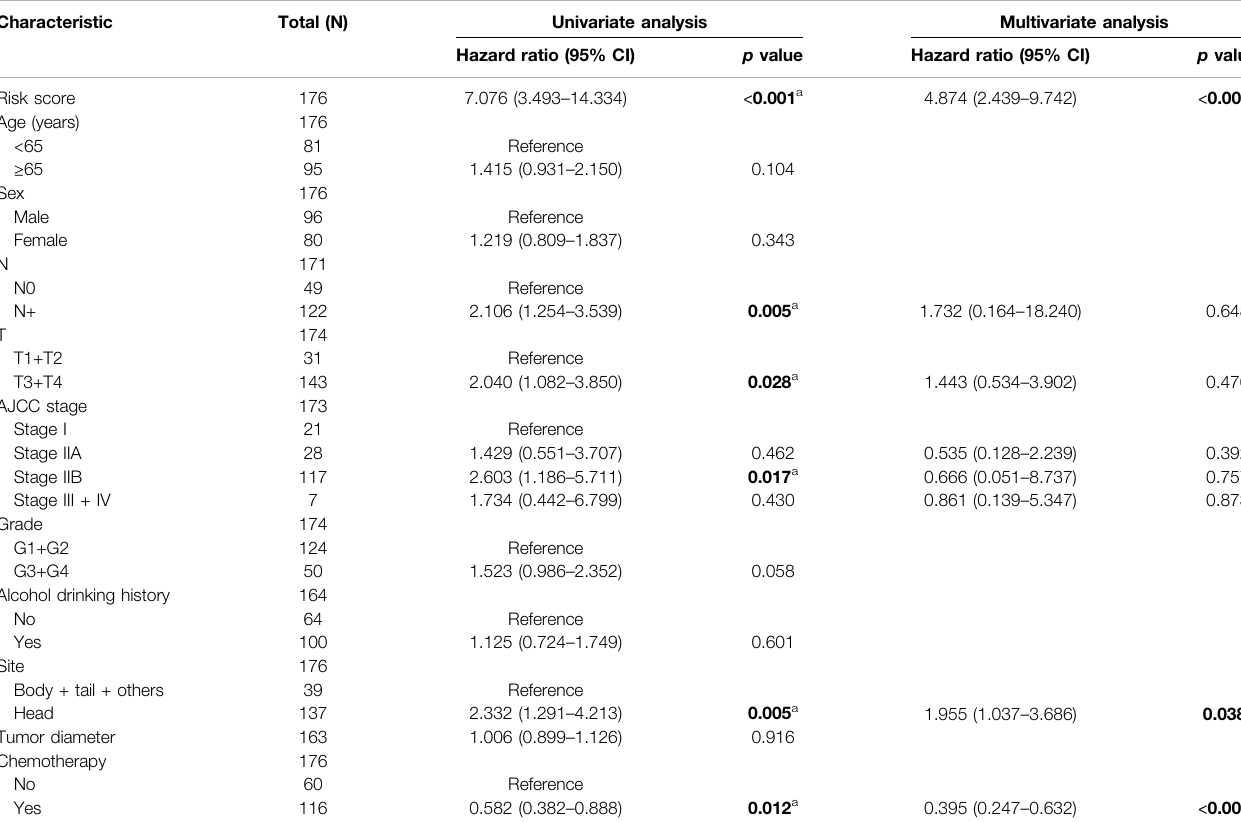
TABLE 1 | Independent prognostic factors for OS in TCGA